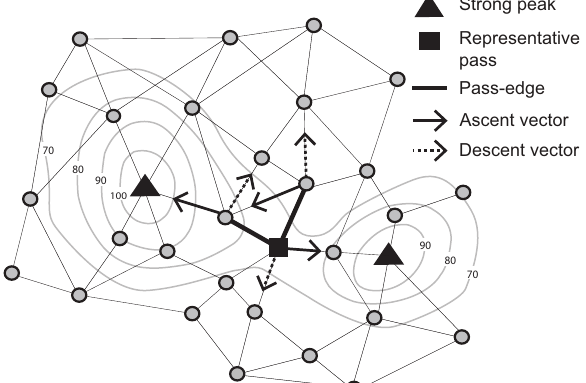
Figure 2. Representative pass (Contour lines describe a scalar field showing the difference in elevation between consecutive contour lines. The sensed values can be estimated using a contour